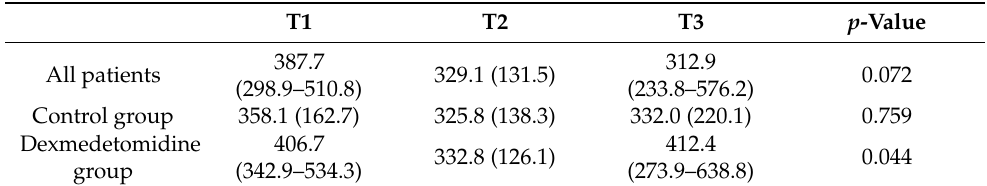
Table 2. Plasma glial fibrillary acidic protein concentration (pg · mL − 1 ) during surgery.